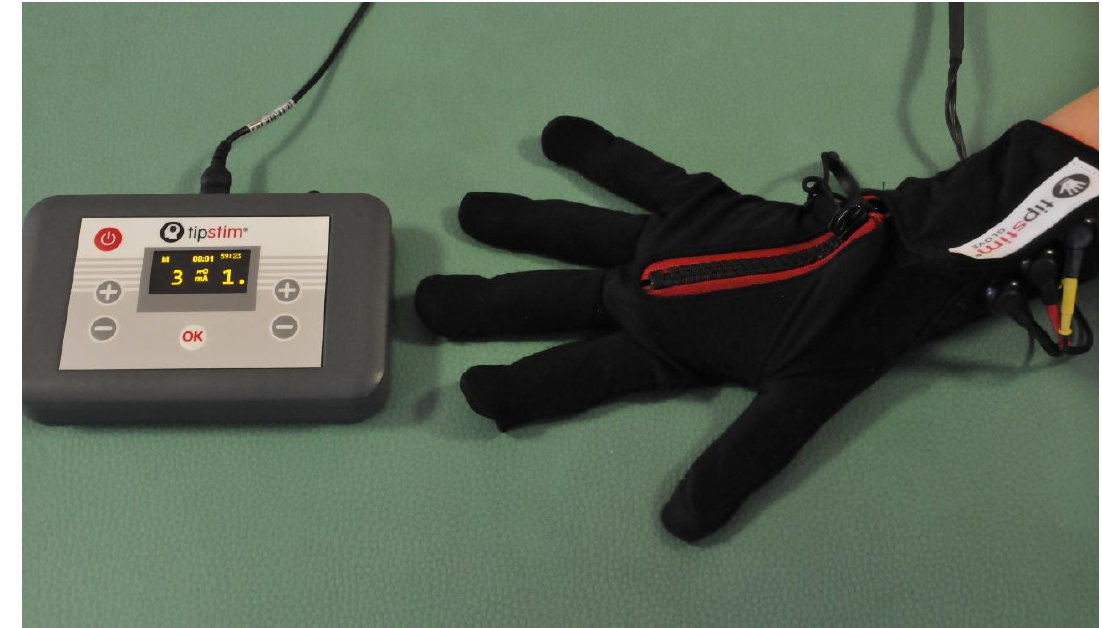
Figure 1. The tipstim ® device.